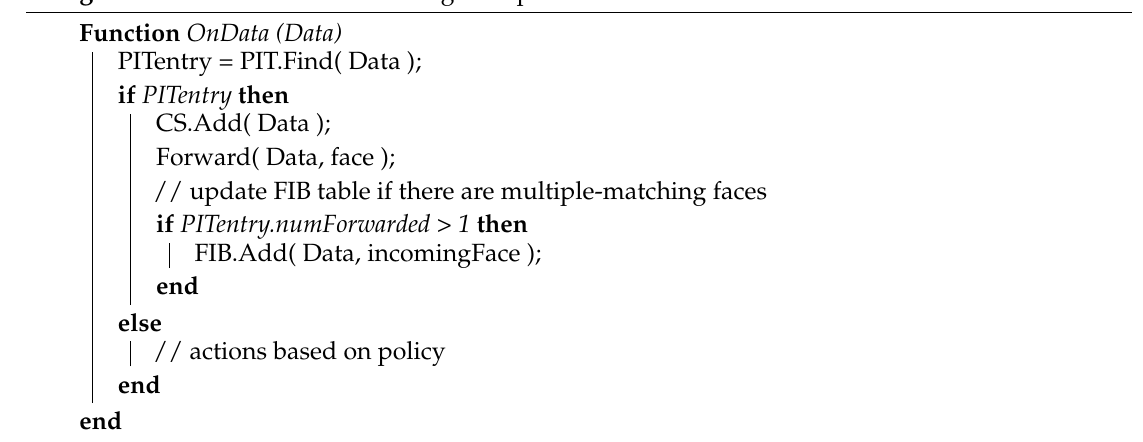
Algorithm 4: Procedure on handling Data packets.